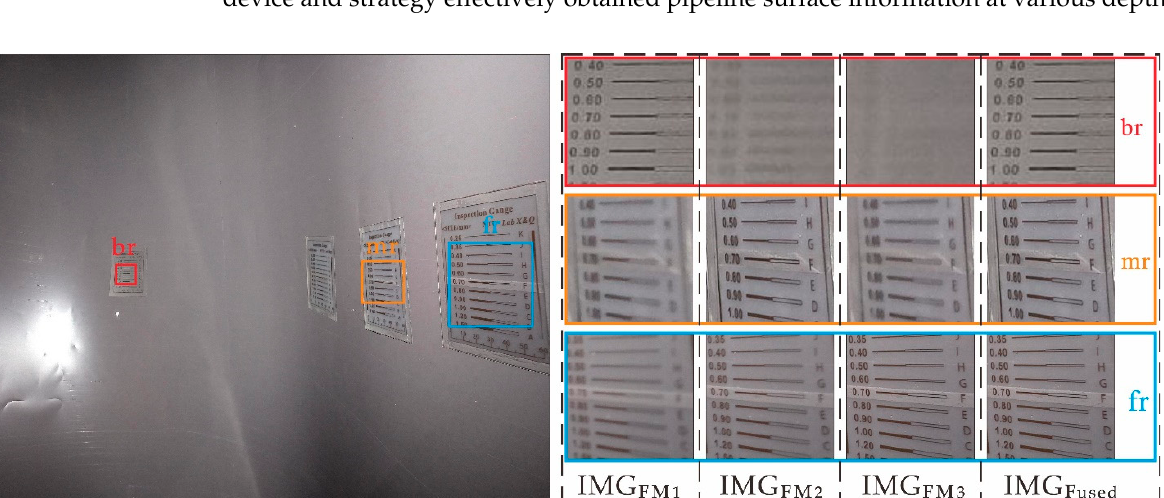
Figure 14. Comparisons of multifocus renderings.